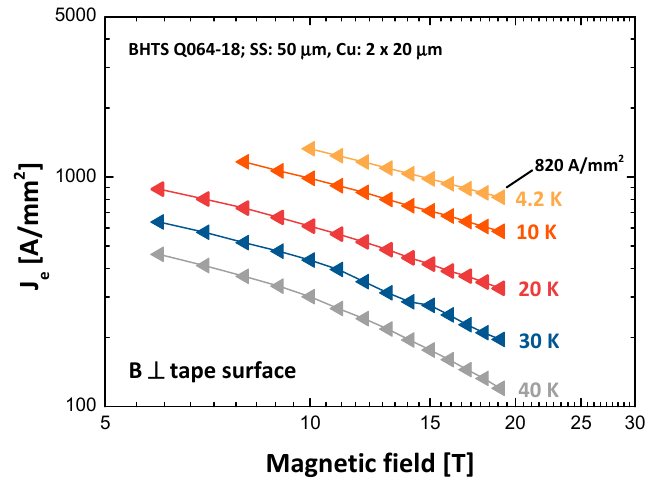
Figure 9. Magnetic field dependence of J e , in the perpendicular orientation, at various temperatures between 4.2 K and 40 K for a 12 mm-wide BHTS tape with a 50 µ m-thick stainless steel substrate and 20 µm Cu stabilizer on each side.